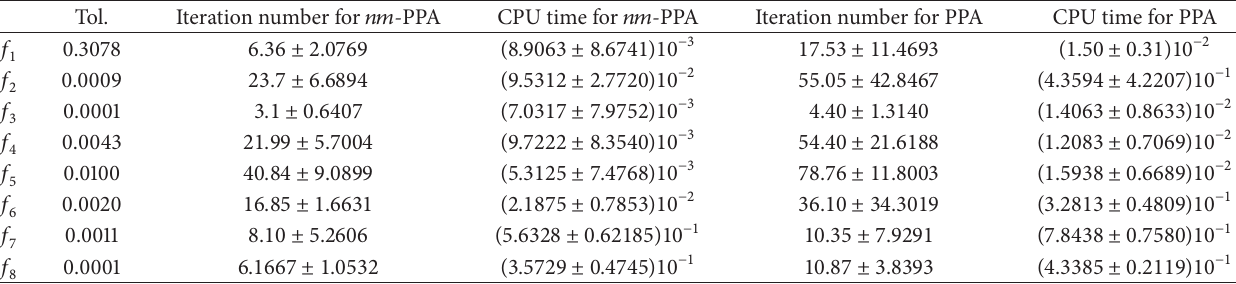
Table 4: Simulation results with tolerance level as termination criterion.